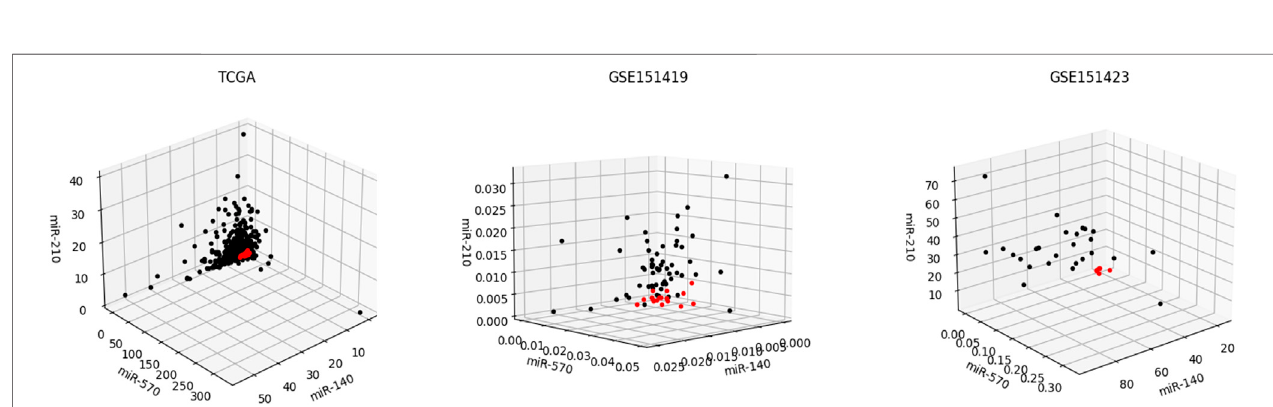
FIGURE 8 | Scatter plots of the expression levels corresponding to each of the fi ve miRNAs on TCGA, GSE151419, and